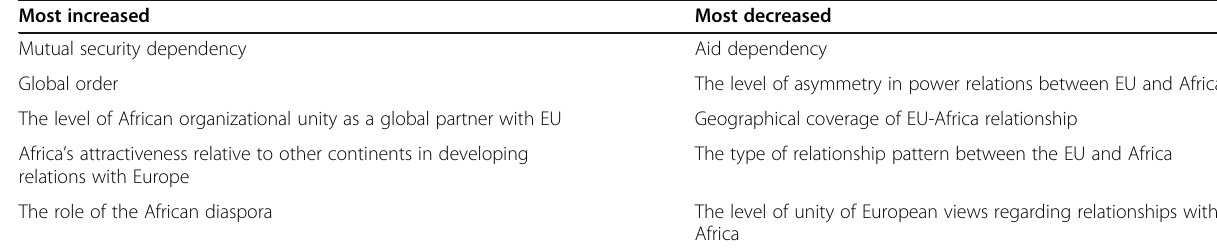
Table 3 Most evolutive drivers of the EU-Africa relationship Most increased Most decreased Mutual security dependency Aid dependency Global